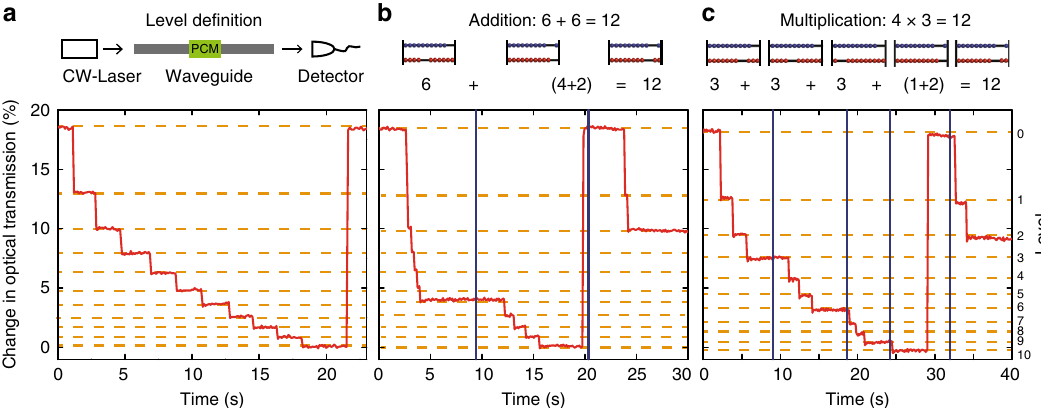
Fig. 2 Elementary arithmetic operations in base ten. a Level de fi nition: Before using a phase-change cell, the levels for the chosen base of operation have to be de fi ned. Therefore the pulse energies are set in such a way that clearly distinguishable and repeatedly accessible levels are obtained. In this example each step downwards consists of a group of fi ve picosecond pulses, the reset pulse of a group of ten ps pulses. b Addition: with the transmission levels de fi ned, ʻ 6 + 6 = 12 ʼ is calculated. By analogy to the operation of an abacus, a carryover is performed when the tenth level is reached and the cell is reset to its initial state. The result ‘ 12 ’ is obtained from one carryover and the fi nal state of the PCM-cell, which is at level 2. c Multiplication: ʻ 4 × 3 = 12 ʼ , computed applying sequential